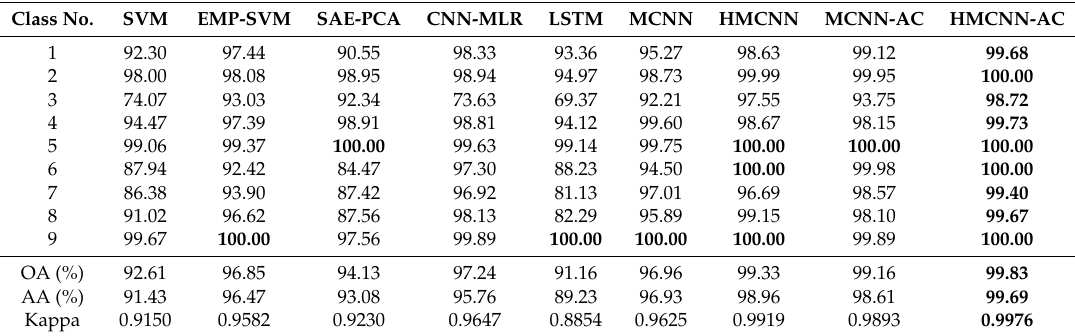
Figure 12. Groundtruth and Classification maps with 10% training samples from KSC dataset. ( a ) Ground truth; ( b ) SVM; ( c ) EMP-SVM; ( d ) SAE-LR; ( e ) CNN-MLR; ( f ) LSTM; ( g ) MCNN; ( h ) HMCNN; ( i ) MCNN-AC; and ( j ) HMCNN-AC. The proposed HMCNN-AC yields the cleanest visualization maps with improved spatial consistency, which is most similar to the groundtruth map. Table 6. Classification accuracy (%) for PaviaU dataset using 5% training samples via different classification algorithms. The three proposed frameworks HMCNN, MCNN-AC and HMCNN-AC outperform other baseline methods in